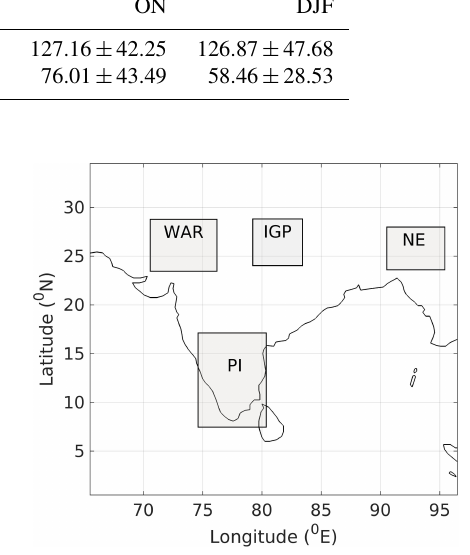
Figure 10. Subregions of the spatial domain.